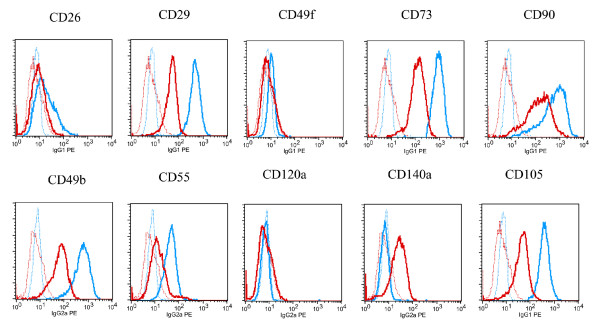
Control of adipocyte differentiation by FACS studies. The adipocytic differentiation was also monitored using flow cytometry with different markers. After growing 14 days some of the cells were harvested and marked with the monoclonal antibodies CD26, CD29, CD49b, CD55, CD73, CD90, CD140a (all Becton Dickinson, San Jose, CA), CD49f, CD120a (both Serotec, Raleigh, NC) and CD105 (Caltag, Buckingham, UK). As a negative control, cells were incubated with the corresponding irrelevant mouse IgG1, IgG2a, IgG2b or IgGM mAbs - therefore, cells became visible in the background. But only if a gene expression is changing in relation to the background after 14 days, can the result be positive. In Figure 4 the cells were colored early in the beginning with a blue marker and after 14 days with a red coloration. Only mAb CD140a clearly showed an increased gene expression after 14 days.